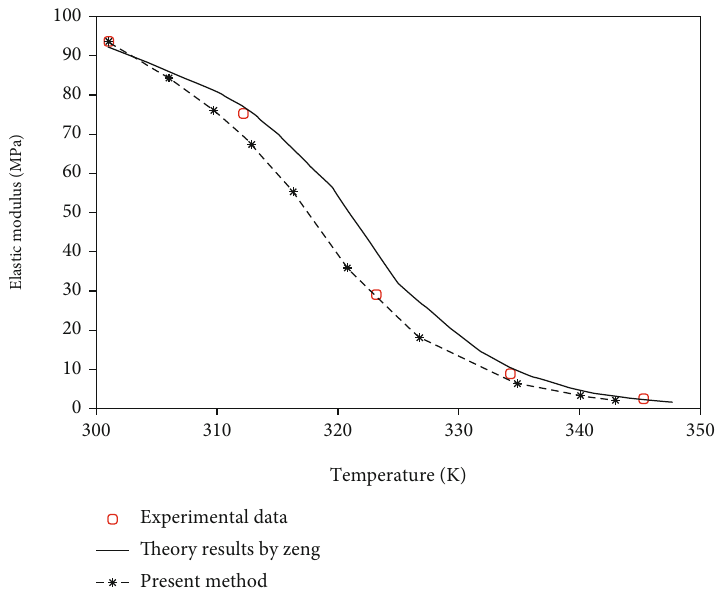
Figure 7: A comparison of elastic modulus with respect to ambient temperature when the FVF = 9 % .